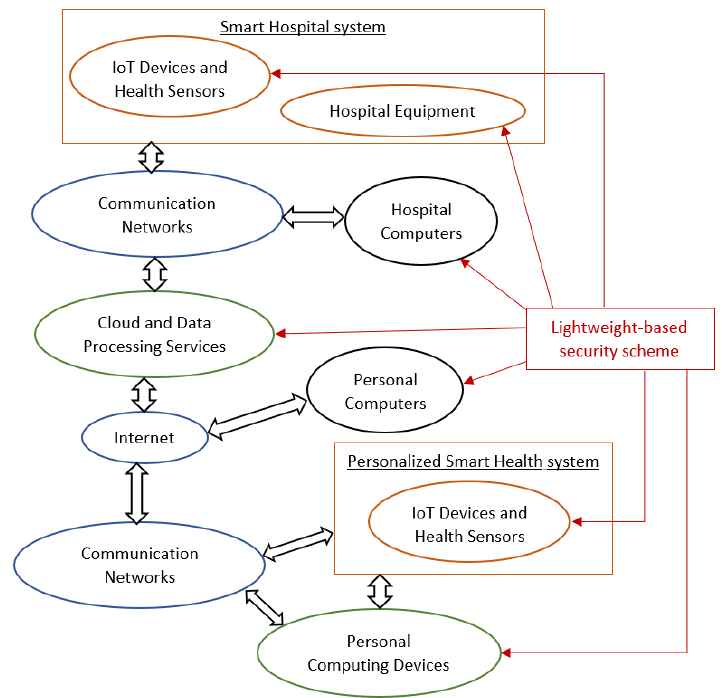
Figure 4. Lightweight-based security scheme.